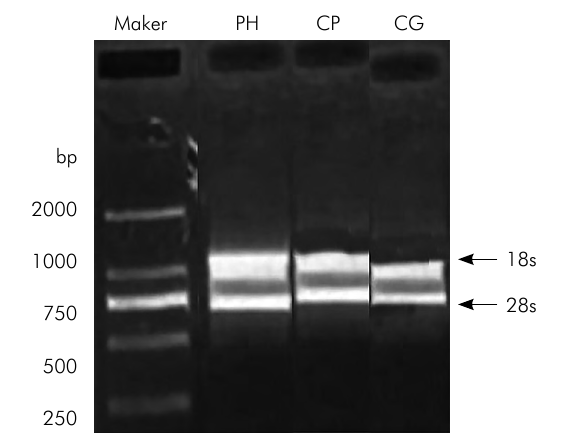
Figure 1. RNA agarose gel